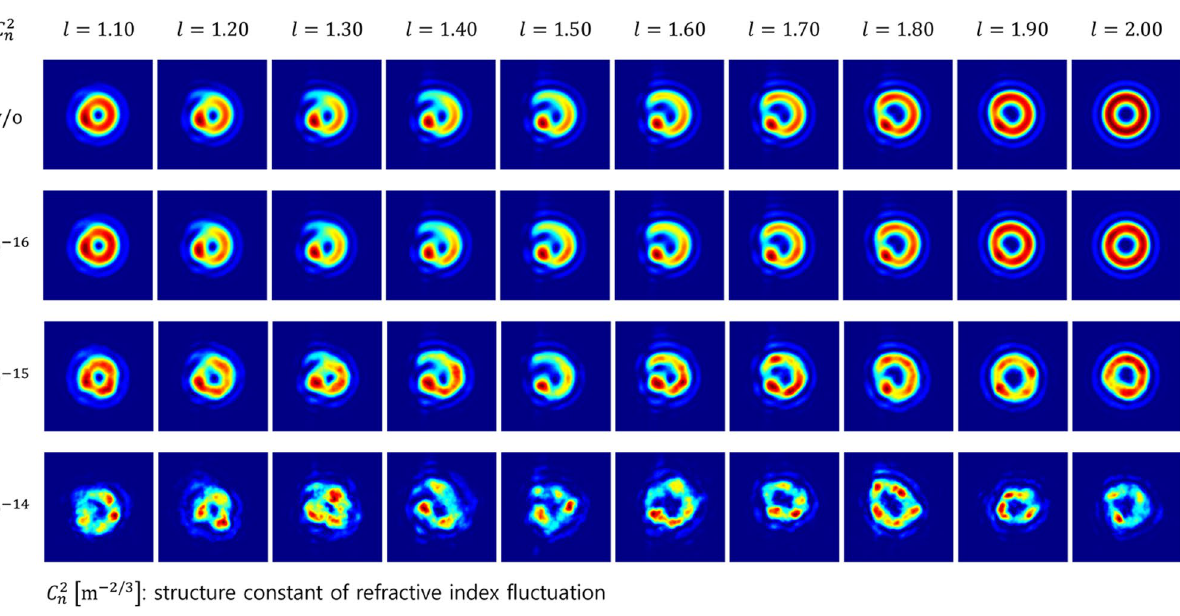
Figure 2. Intensity profiles of the received fractional OAM beams over 1000-m AT channels with different C Here, each image is 200 × 200 pixels